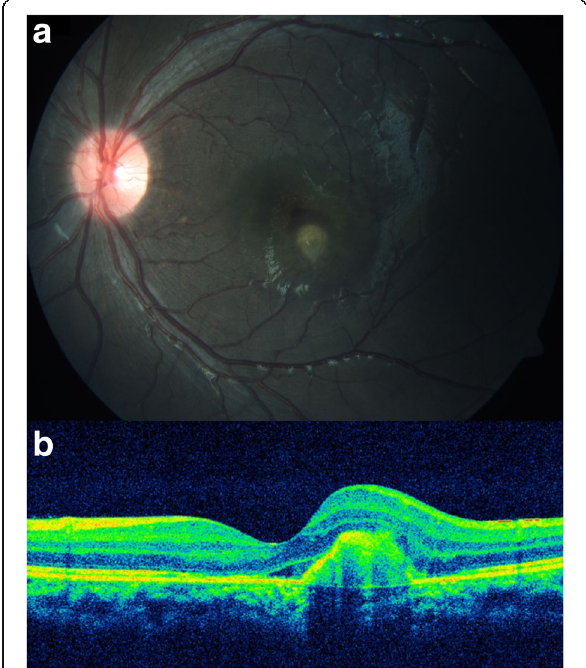
Fig. 1 a Color fundus photograph of the left eye on presentation. b Optical coherence tomography through the lesion showing the choroidal neovascular membrane, retinal thickening, and subretinal fluid